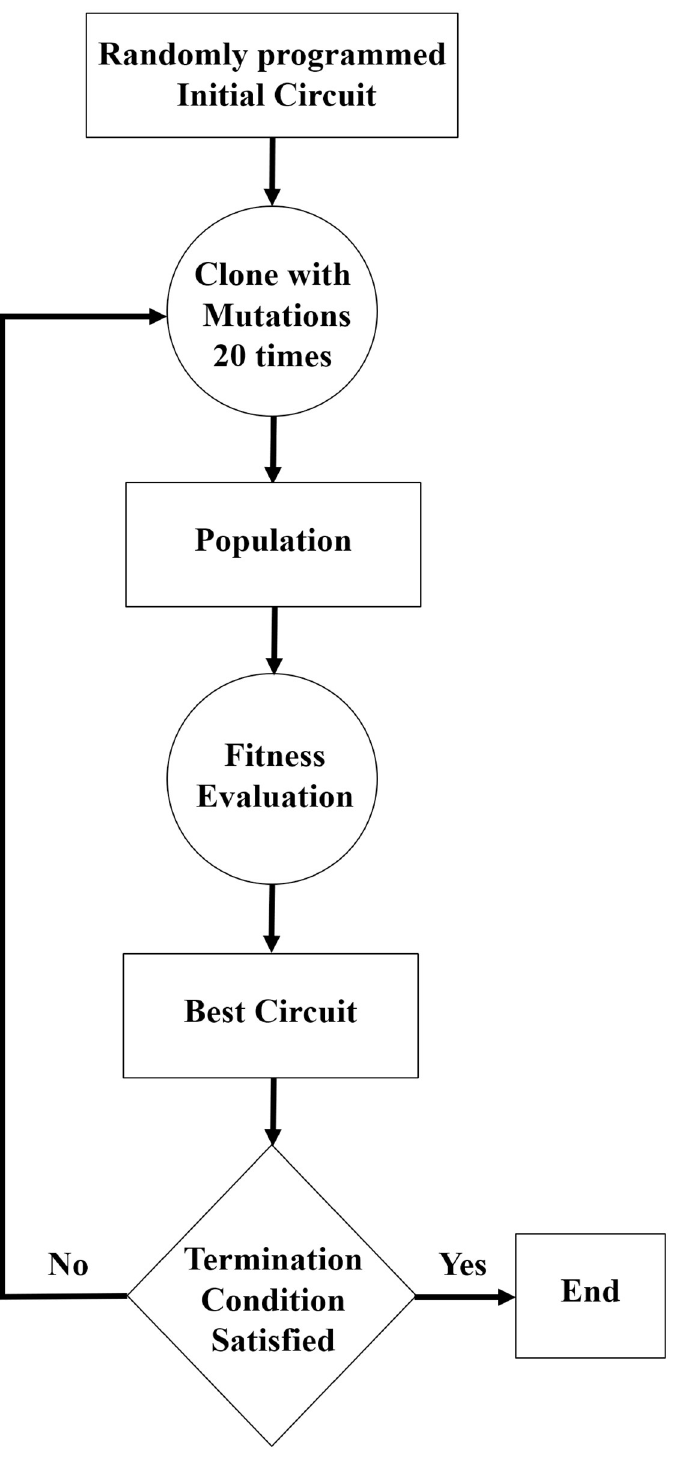
Fig 4. Flowchart for the genetic algorithm used in this